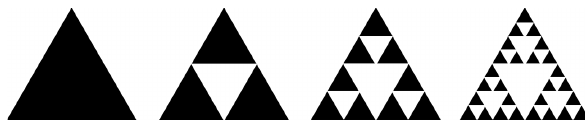
Figuur 5: Die Spierpinski-driehoek (die eerste vier ordes). (Aangepas uit Keidel, 1995, p. 109)